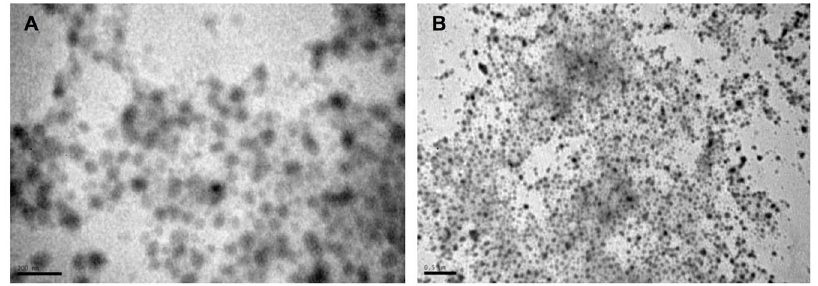
Figure 1. Representative TEM micrographs of PNIPA nanohydrogel. Scale bar of the image A is 200 nm and image B is 0.5 m m.